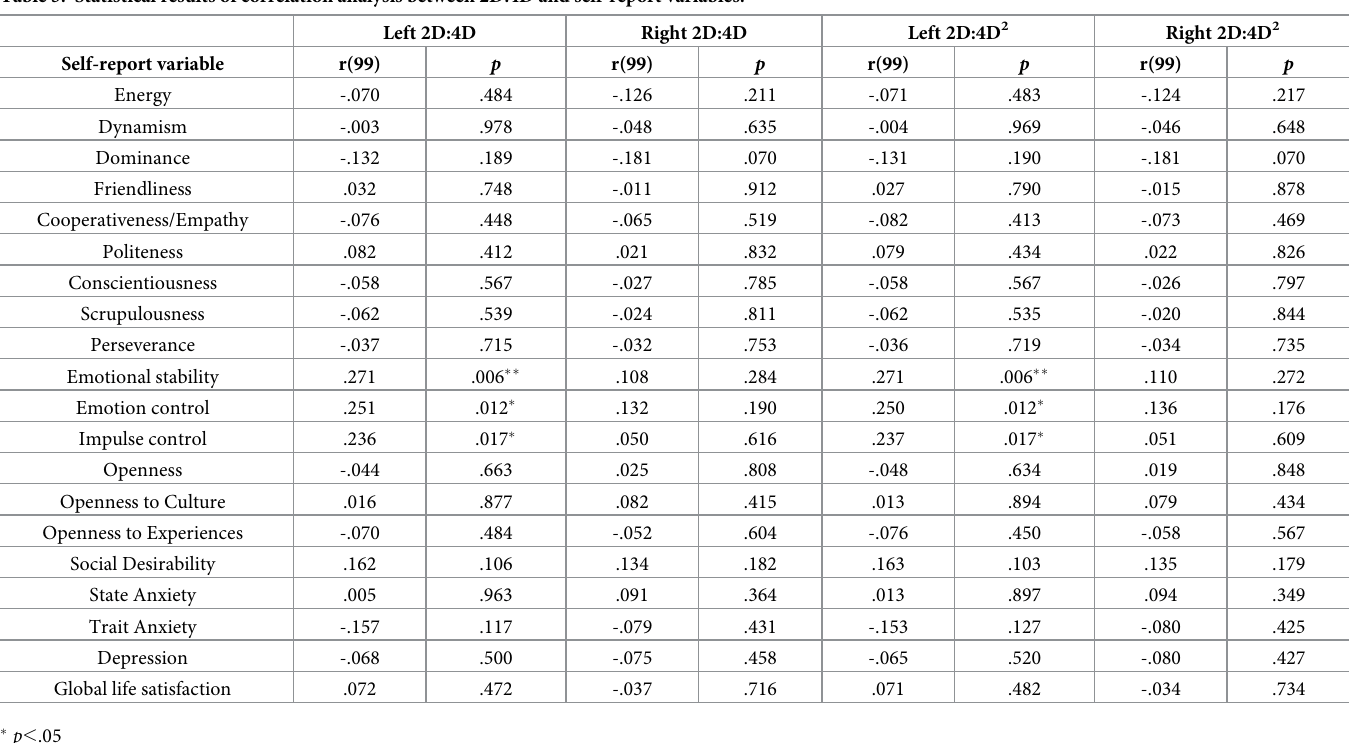
Table 3. Statistical results of correlation analysis between 2D:4D and self-report variables.